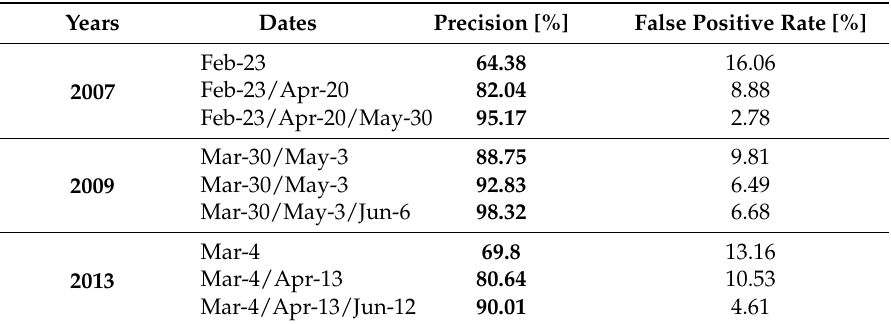
Table 4. Precision [%] and false positive rate [%] for 1 or 2 or 3 dates (2007, 2009 and